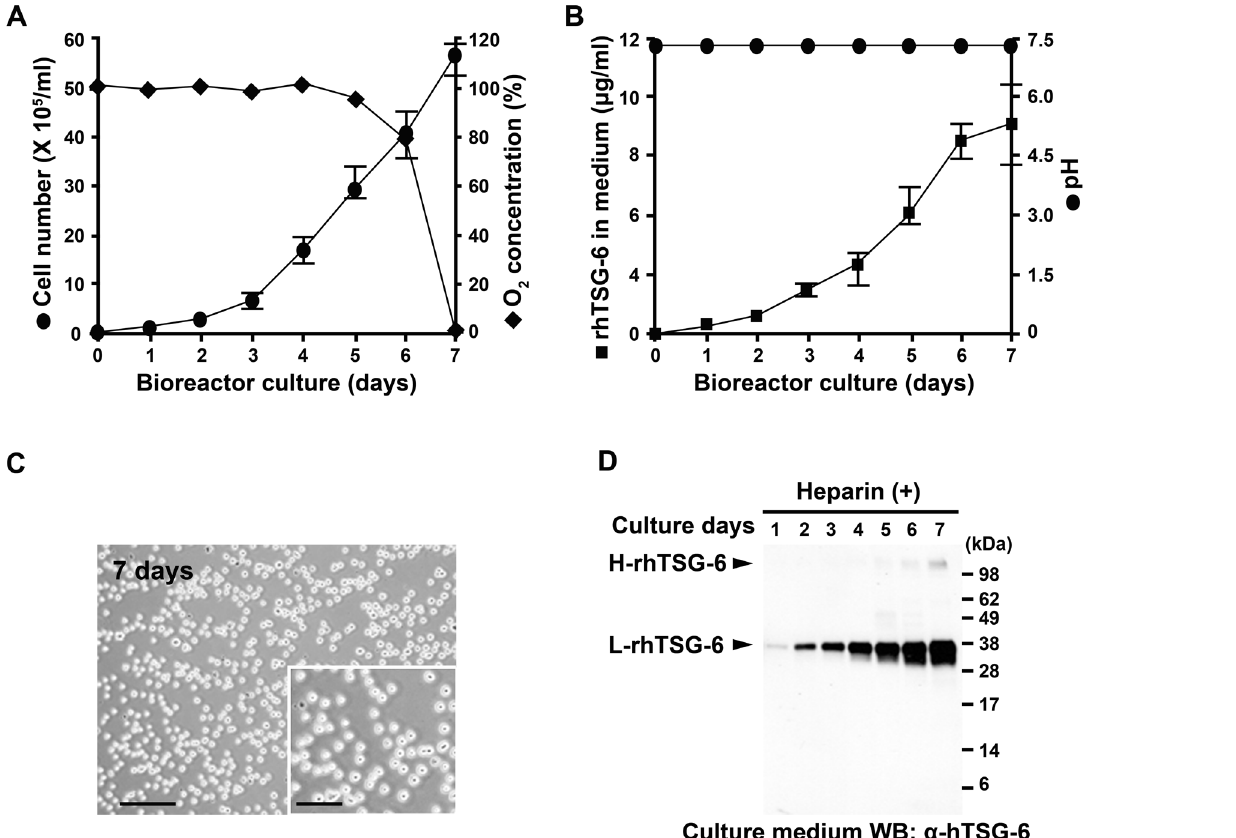
Fig 3. Synthesis of rhTSG-6 by culture of rhTSG-6/CHO-S cells in OCDPF medium and in a bioreactor that controlled pH. (A) Expansion of cells and oxygen saturation. (B) Yield of rhTSG-6 and pH of medium. (C) Photomicrographs demonstrating that rhTSG-6/CHO-S cells are largely single-cell suspensions. Scale bars = 100 μ m and 50 μ m (insert) (D) Yield of monomeric rhTSG-6. Western blot of medium with antibodies to hTSG-6. Values in (A) and (B) are means of 3 replicates.